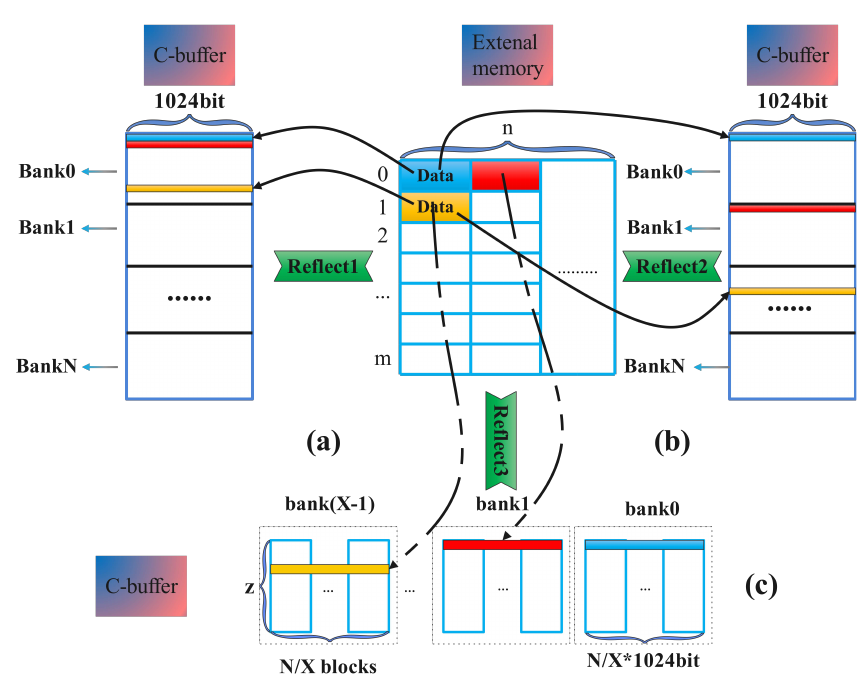
Figure 5. The mapping methods/algorithms: ( a ) TPM; ( b ) SPM; ( c ) SPM for multiple